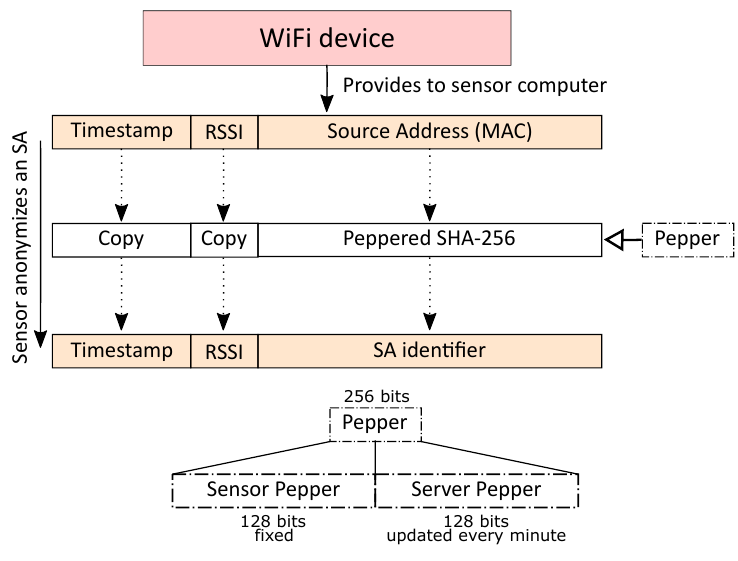
Figure 2. (From [5]) Scheme of the anonymization procedure executed by the sensors. The pepper consists of a concatenation of a fixed 128-bit sensor pepper and a time- varying 128-bit server pepper . The central server maintains an up-to-date array of 20 server peppers for a duration of 20 min that sensors periodically fetch using an HTTPS link with transport security layer (TLS). Sensors use each server pepper for a specific one-minute time frame . Server peppers are generated using a pseudo random number generator